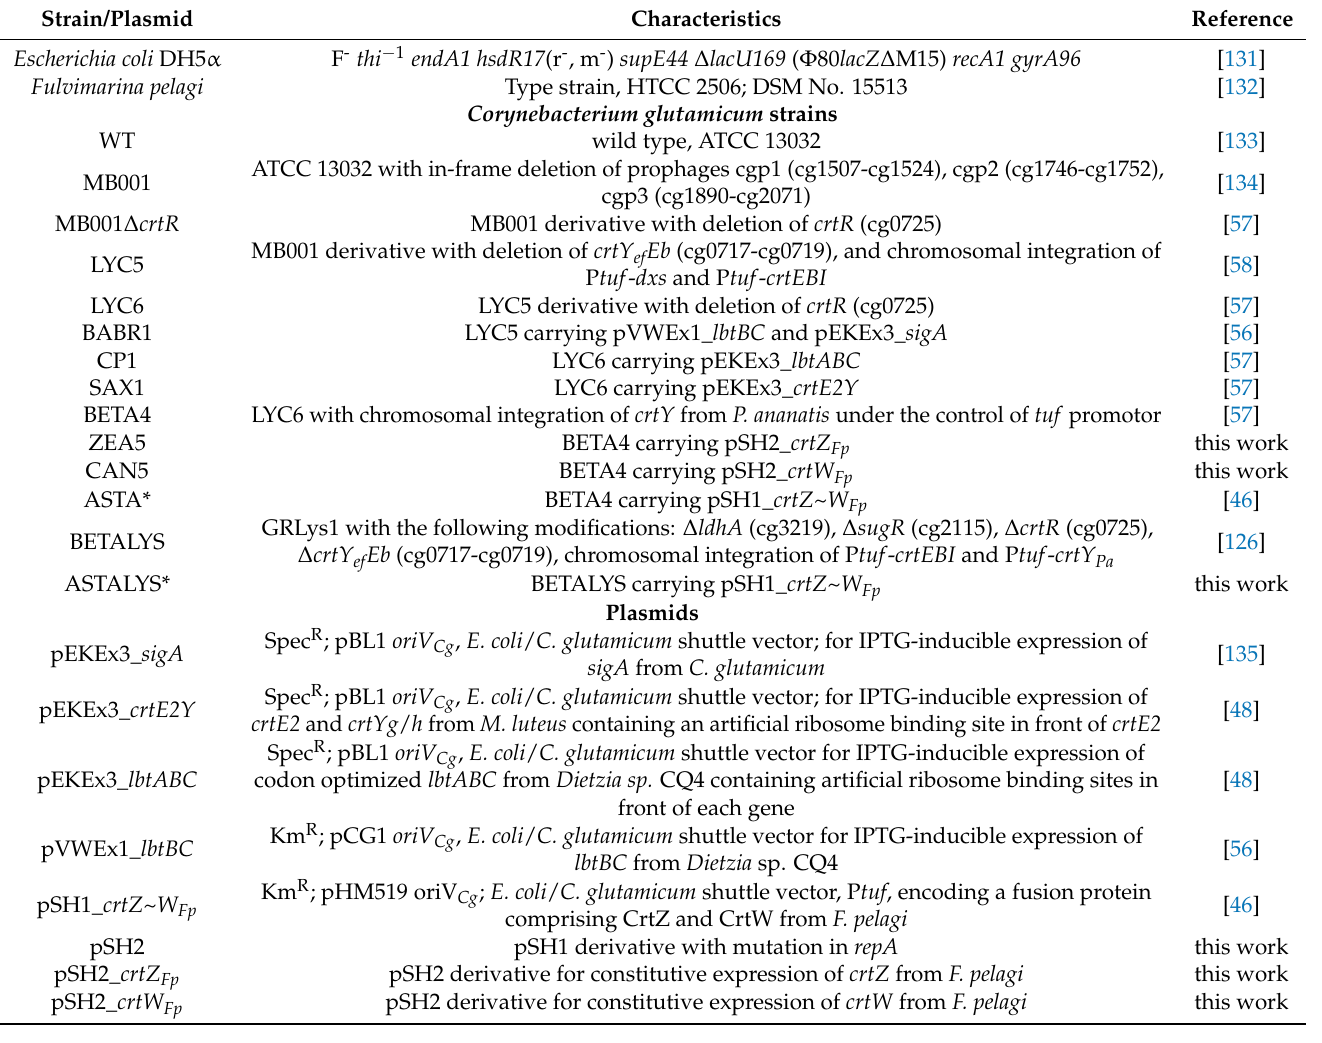
Table 1. Strains and plasmids used in this